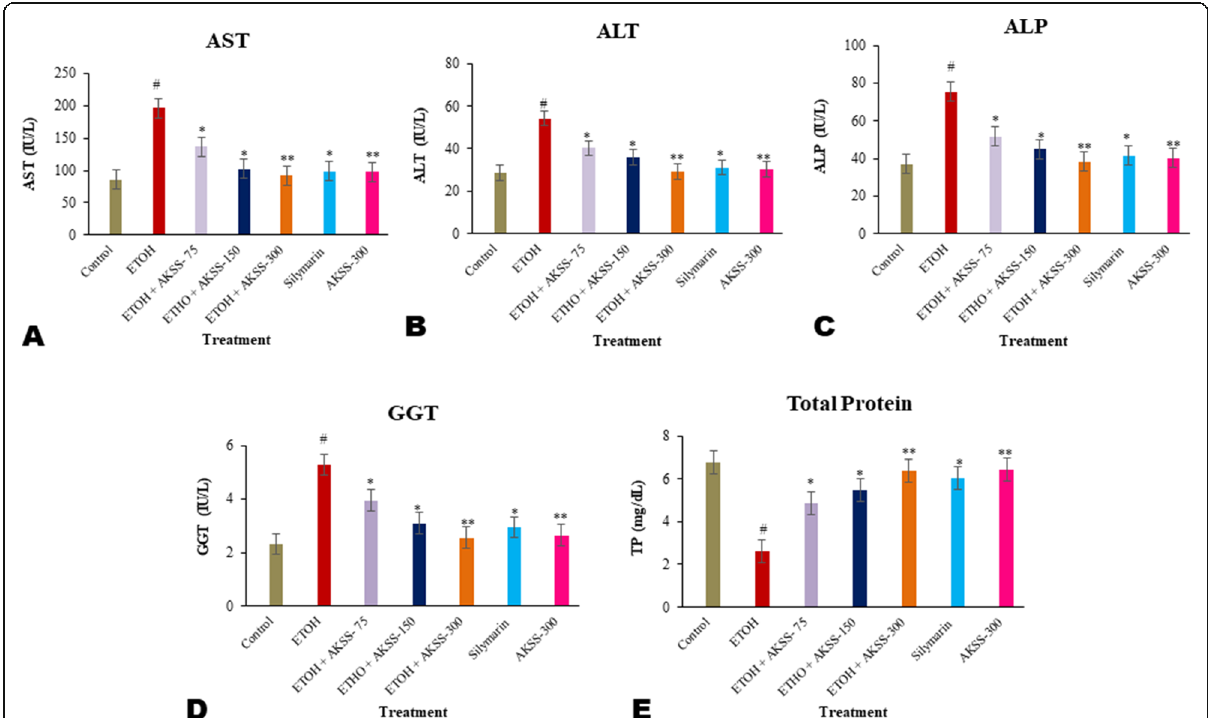
Fig. 3 Determination of biochemical parameters (Liver function test). The values are expressed as the mean±SEM. Significantly difference # P <0.001 compared to the untreated control group and * P <0.001, ** P <0.001 significantly difference compared to the ethanol treated group. Group-I: Control; Group- II: Ethanol treated; Group-III: ASKK-75mg/kg; Group-IV: AKSS-150mg/kg; Group-V: AKSS-300mg/kg; Group-VI: Silymarin – 100mg/kg; Group-VII: AKSS-300